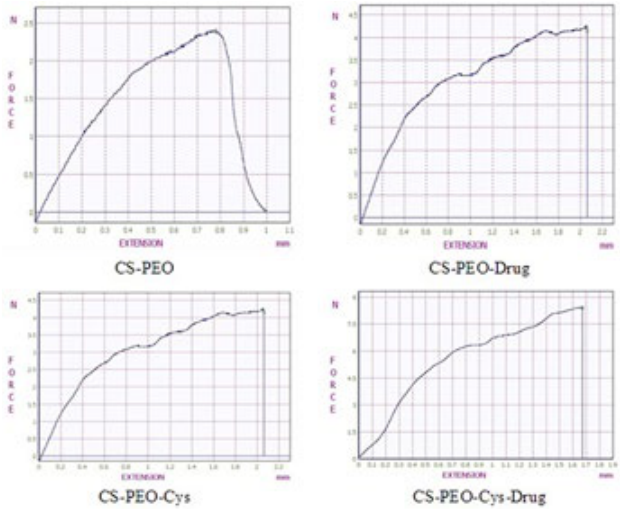
FIGURE 6 - Mechanical analysis of CS/PEO, CS/PEO/Cys, CS/PEO/drugs and CS/PEO/Cys-drugs fibers.